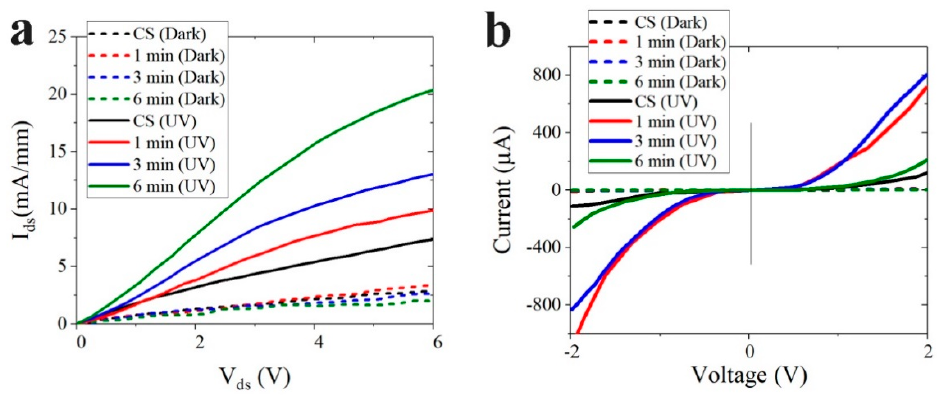
Figure 8. I-V characteristics of ( a ) the HEMT-based and ( b ) IDE pattern-based UV